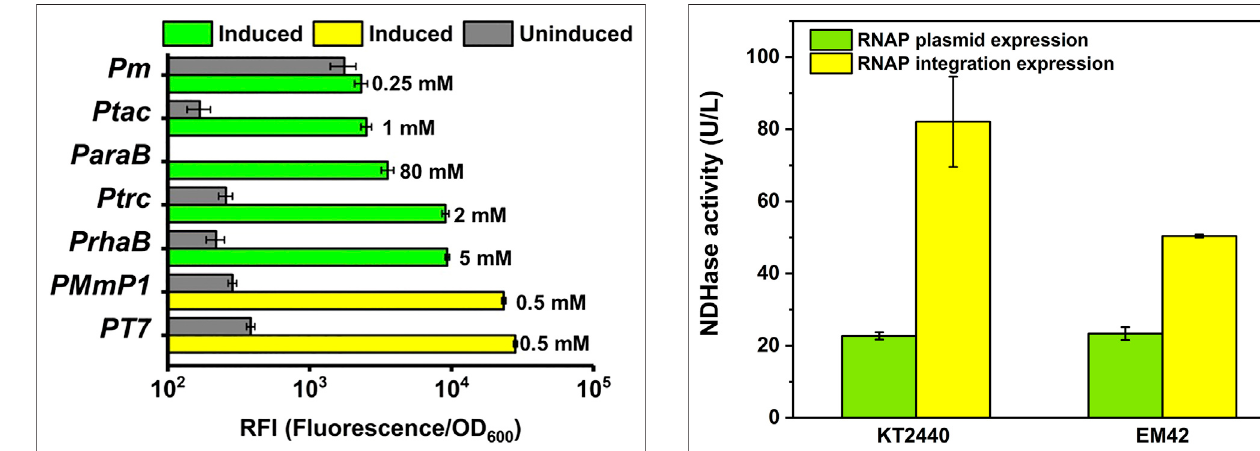
P m expression system ( Supplementary Figure 4 ). The optimal condition of the T7 expression system was considered the same as that of the MmP1 expression system.